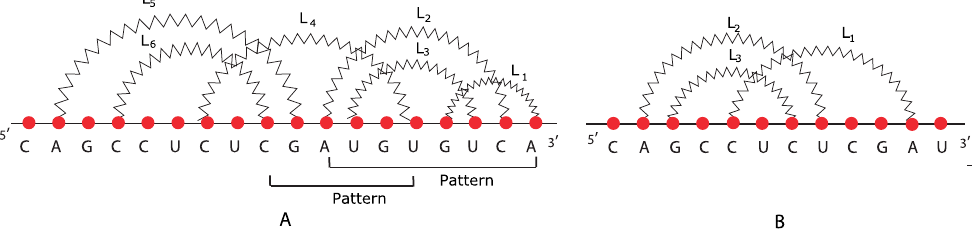
Figure 7: (a) The structure and (b) the